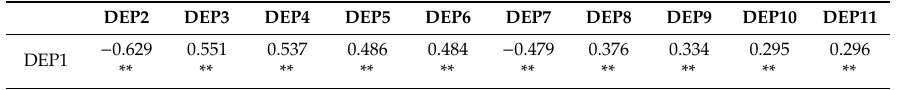
Table A1. Correlation coe ffi cients from Pearson correlation analysis between observed variables in depression.